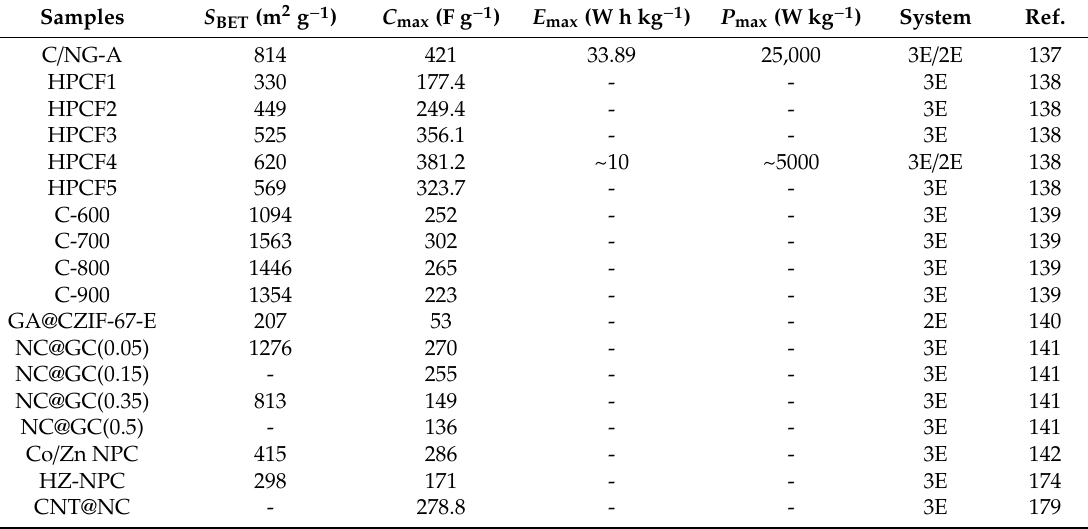
Table 8. The electrochemical capacitive properties of other MOF-derived carbon / carbon composites.